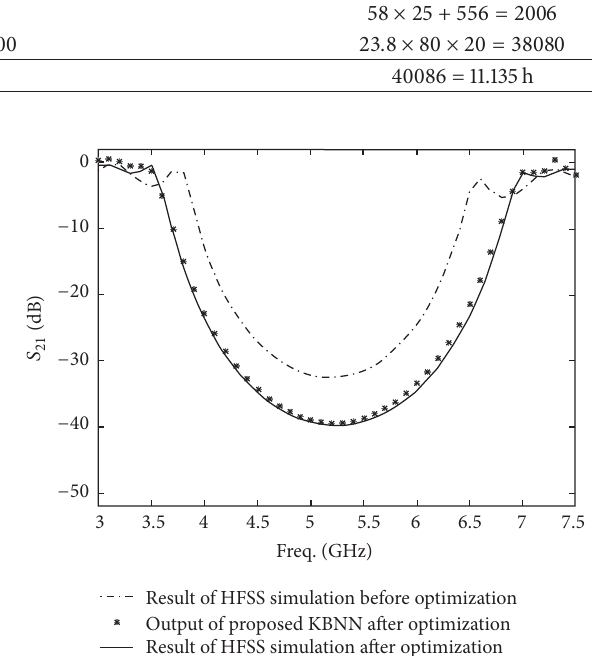
Figure 13: Comparison of papilionaceous dual-plane EBG before and after